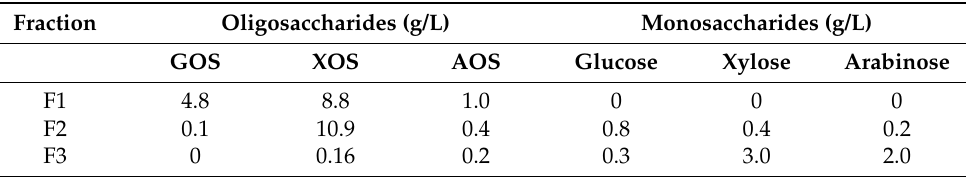
Table 1. Composition in oligomeric and monosaccharide form (g/L) of fractions collected by gel permeation